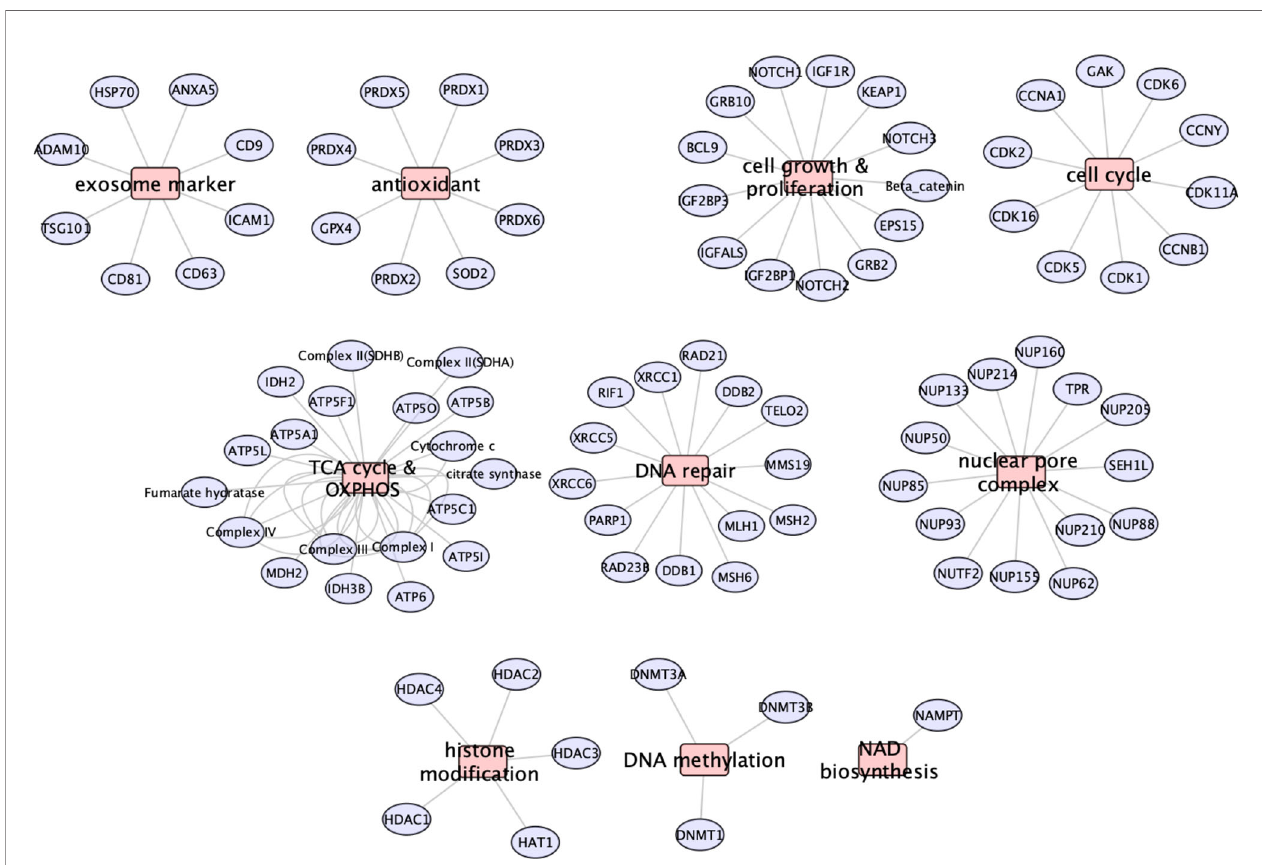
FIGURE 7 | Summary of the major proteins and classes identi fi ed in hESC-derived EV by proteomic analysis. Major protein classes show that EV contain exosome markers, antioxidant enzymes, cell growth and proliferation, cell cycle, metabolic (TCA, OXYPHOS, NAMPT), DNA repair, nuclear pore complex and epigenetic modi fi er (HDAC, DNMT)